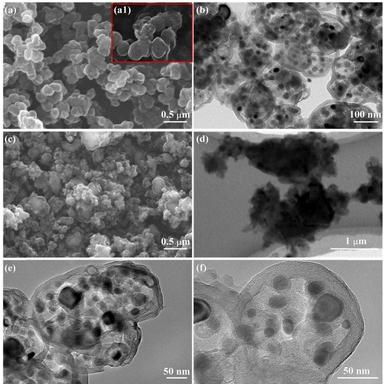
(a) SEM and (b) TEM images of CoFeCN@C; (c) SEM and (d) TEM images of CoFeCN; TEM images of (e) CoFeCN@C and (g) E-CoFeCN@C.